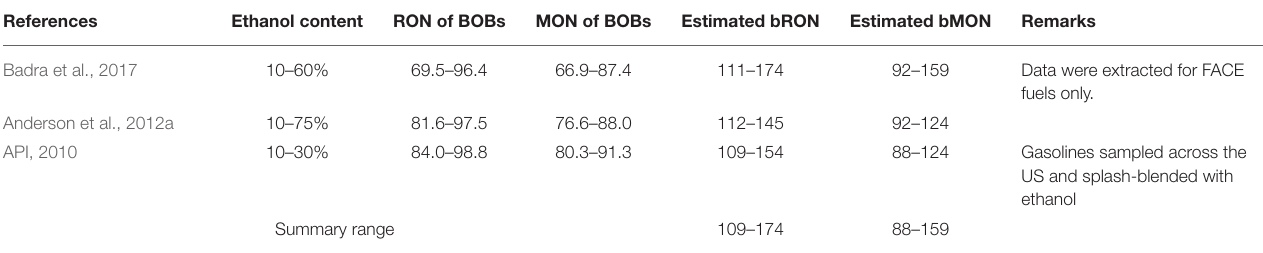
TABLE 2 | Effects of ethanol blending on the measured RON and MON of gasolines at different concentrations and for different blendstocks reported in the literature.